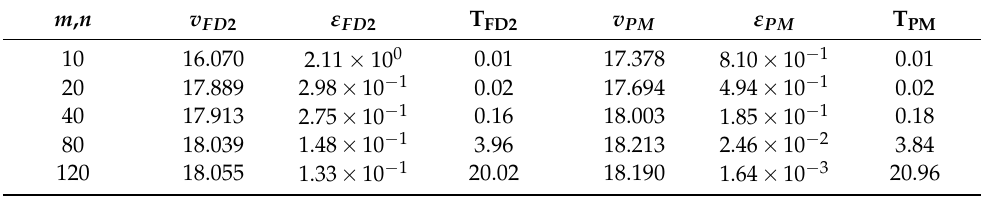
Table 1. Numerical results of fractional European call option pricing under Test Problem 1.